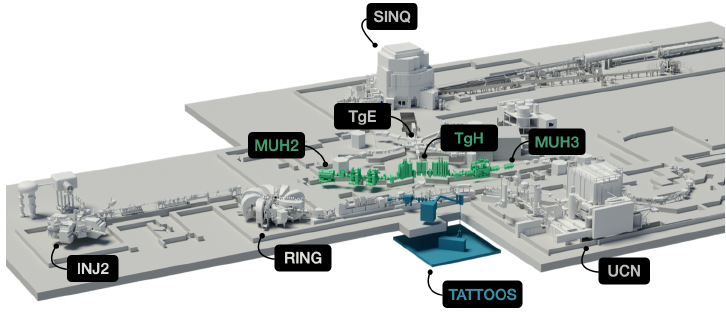
Figure 8. Overview of the HIPA accelerator complex including the HIMB beamlines and the new isotope production target station TATTOOS